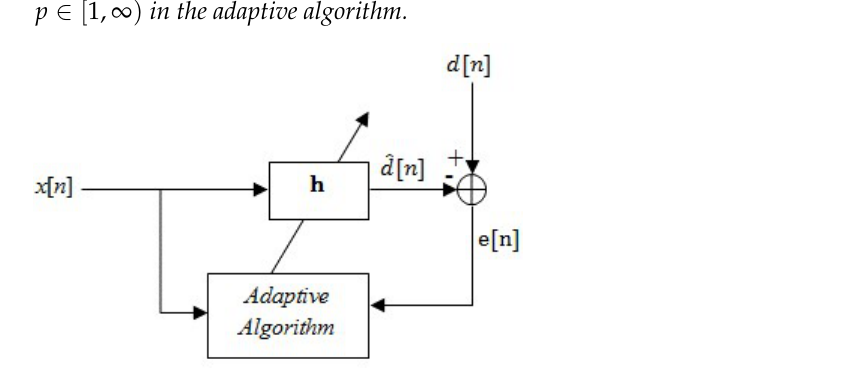
Figure 2. An adaptive filter consisting of a shift-variant filter h with an adaptive algorithm for updating the filter